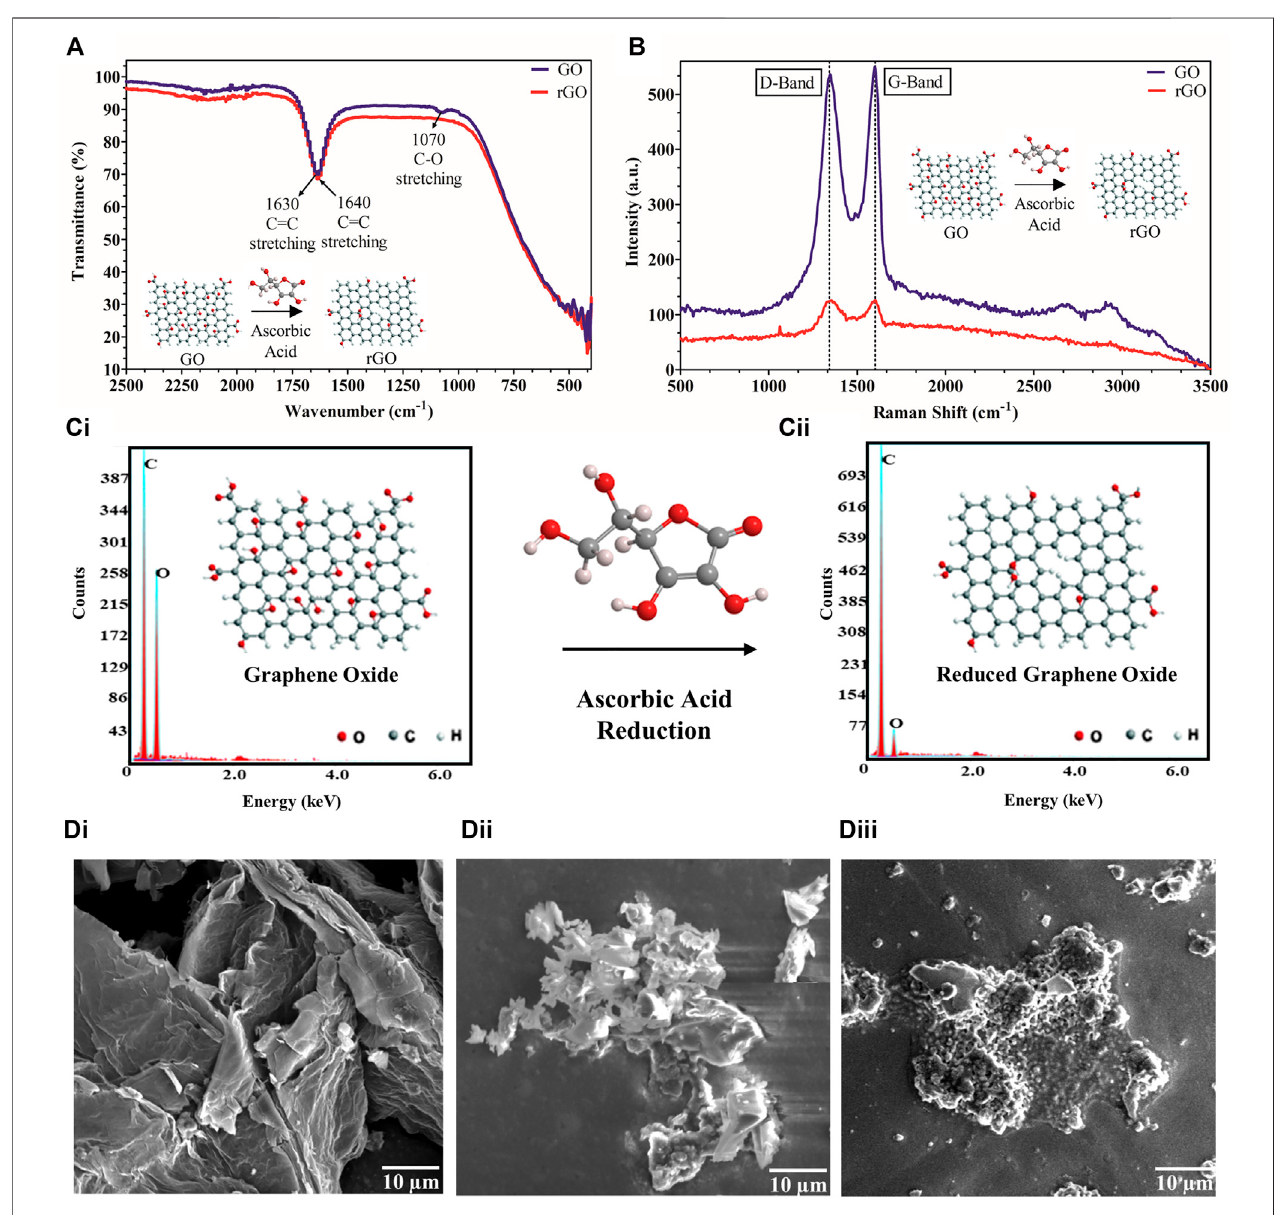
FIGURE 2 | rGO synthesis and conjugation characterization: (A) FT-IR spectrum of GO shows peaks at 1,630 cm − 1 (C = C stretching) and 1,070 cm − 1 (C-O stretching)whereasrGOshowsonlyasinglepeakat160 cm − 1 (C=Cstretching); (B) RamangraphshowingahigherG-bandthanD-bandby10a.u.intensityforGObut no such difference for rGO; (C) EDX spectrum showing (Ci) . higher amount of oxygen in GO and (Cii) . lower amount of oxygen in rGO; (D) scanning electron micrographs of (Di) . rGO, (Dii) . BACE1 Ab deposited on rGO, (Diii) . BACE1 Ag bound to BACE1Ab on